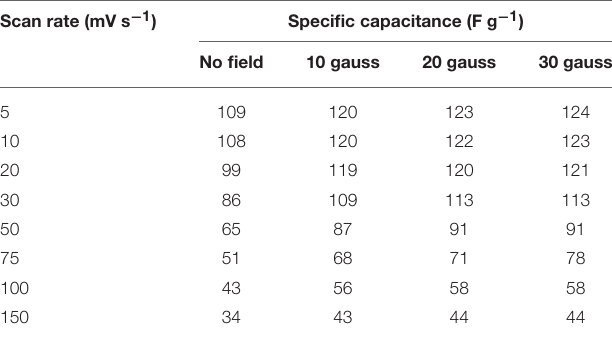
TABLE 6 | Values of specific capacitance at different scan rate under varying magnetic field (in three electrode configuration). Scan rate (mV s − 1